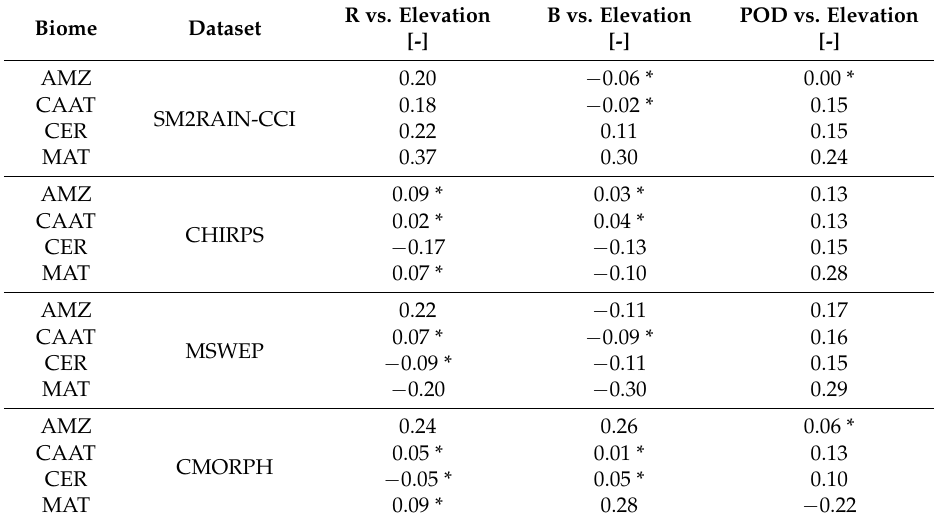
Table 11. Correlation coefficients for the R, B, and POD scores against elevation at the pixel scale for each rainfall dataset.